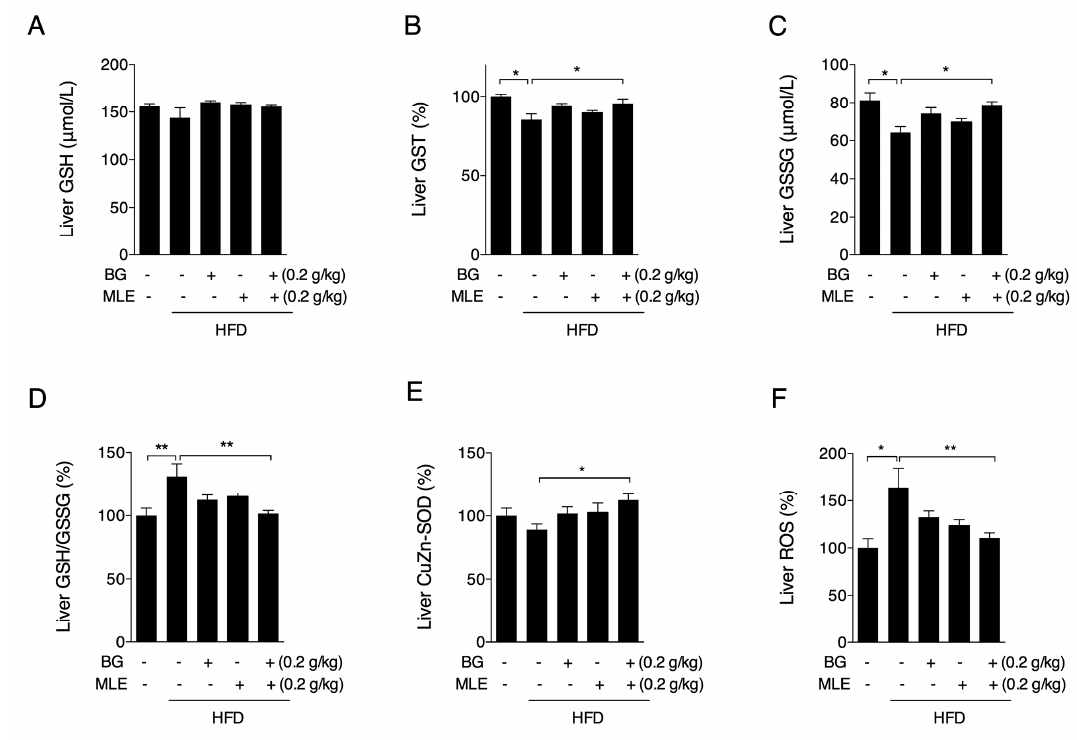
Figure 6. Effects of BG and MLE on liver oxidative stress. Liver glutathione (GSH) ( A ); liver GST ( B ); liver GSSG ( C ); liver GSH/GSSG ( D ); liver Cu-ZnSOD activity ( E ); and liver ROS ( F ) in male C57BL/6 mice fed a control diet or a high-fat diet supplemented with BG or/and MLE for 12 weeks. The data are the mean ± SEM, n = 10. * p < 0.05, ** p < 0.01 vs. related control.